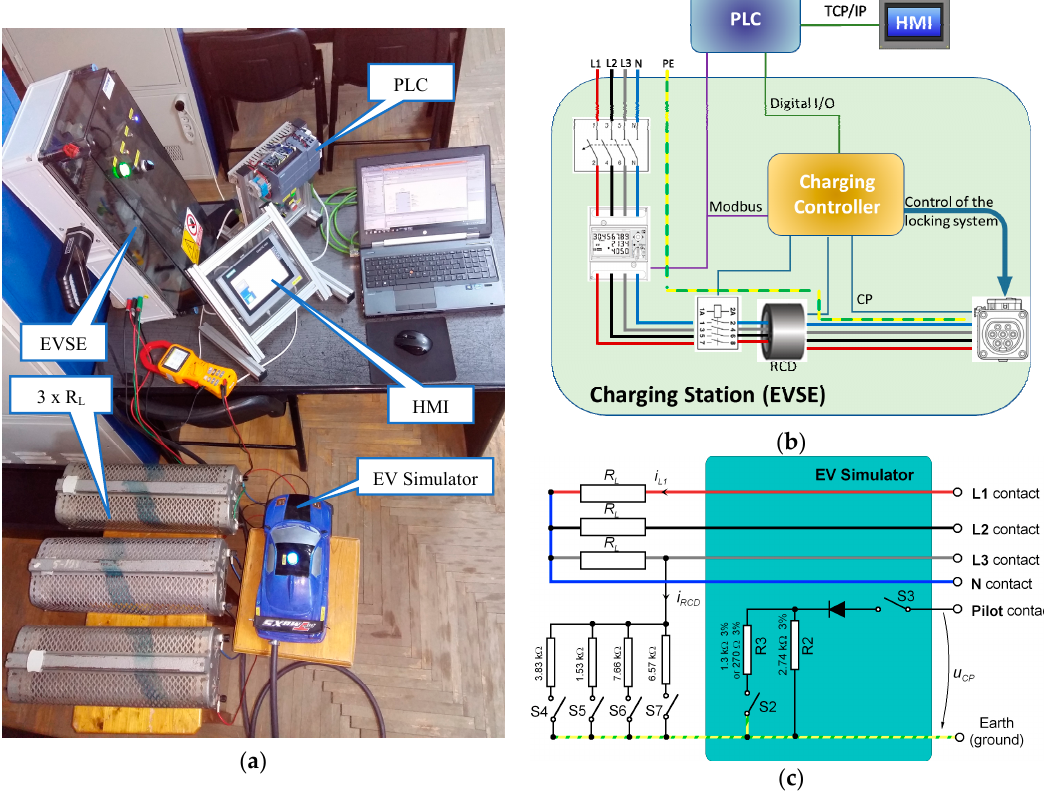
Figure 3. Experimental arrangement: ( a ) Experimental setup; ( b ) electric vehicle supply equipment (EVSE) Circuit block diagram; ( c ) electrical vehicle (EV) Simulator.